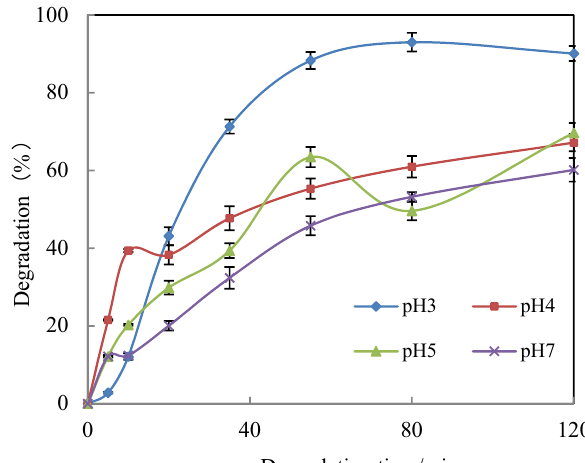
Figure 1. Effect of pH on [C 4 mim][BF 4 ] degradation. ([[C 4 mim][BF 4 ]] = 1 mmol/L, [AC] = 0.15 g, [ZVZ] = 0.15 g and ultrasound frequency = 45 kHz at 30